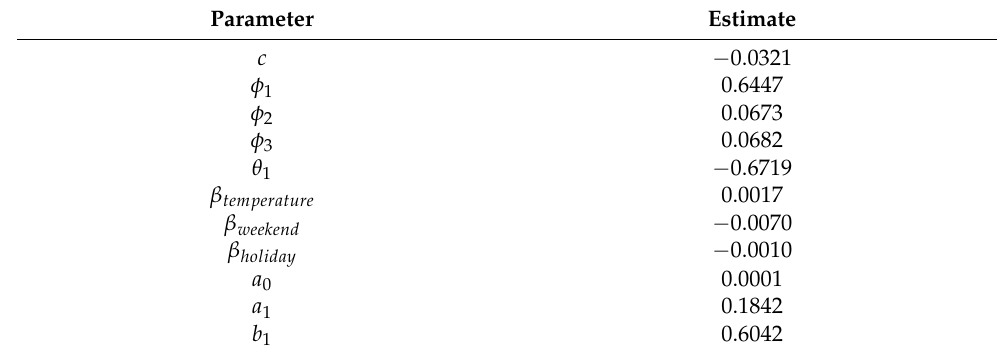
Table 3. Parameter estimations of the ARIMA ( 3,0,1 )( 0,1,0 ) perature, weekend, and holiday